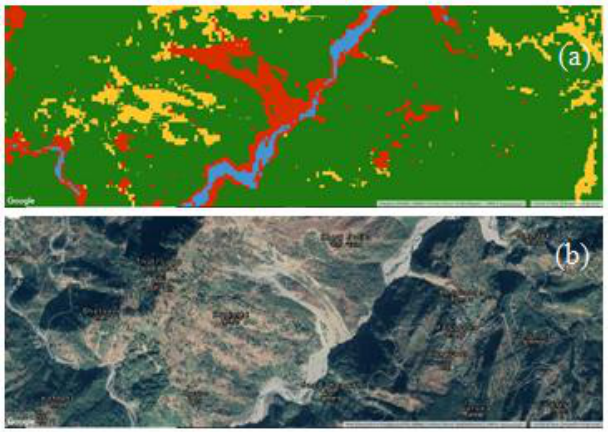
Figure 7. Location near Ukhimath identified as Landslide